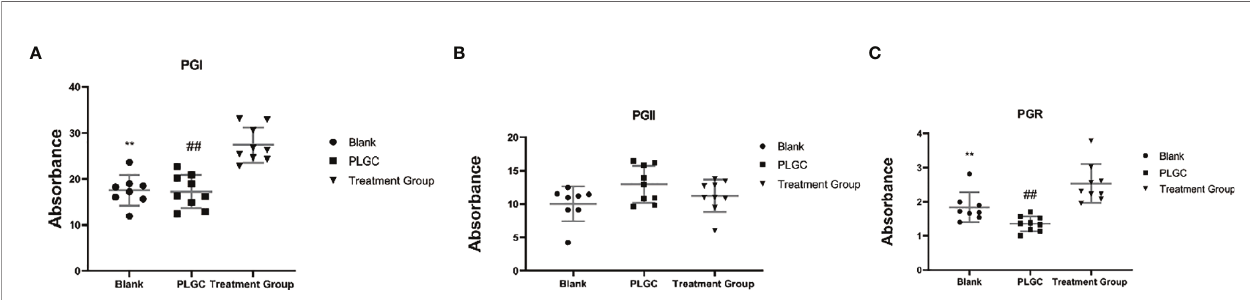
FIGURE 5 | Comparison of serum PG I, PG II, and PGR in the rats of each group. (A) The level of serum PG I in each group. (B) The level of serum PG II in each group. (C) The level of serum PGR in each group. ** P < 0.01 vs. Blank; ## P < 0.01